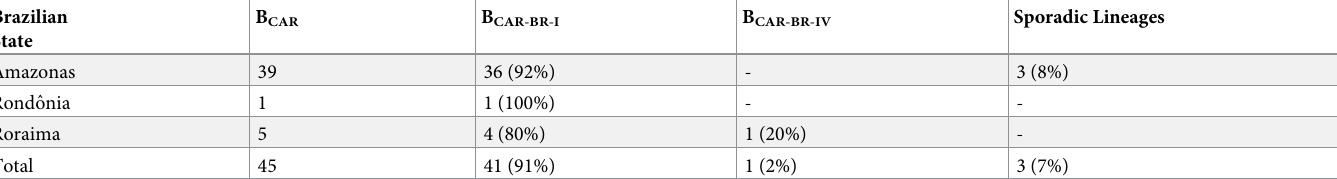
Table 3. Subtype B CAR sub-clade assignment.